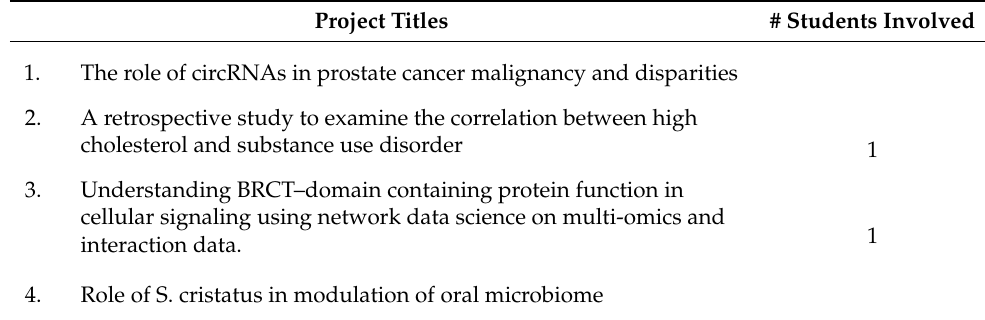
Table 1. Collaborative projects selected for mini-grants by our Sub-award Review Organization Committee.